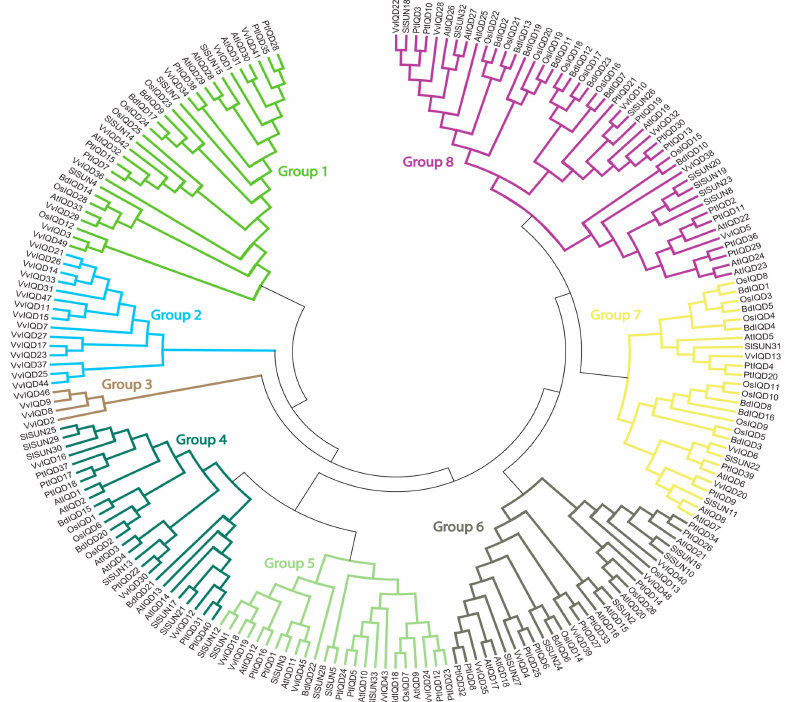
Figure 3. Phylogenetic relationships of V. vinifera VvIQD genes with A. thalinana , P. patens , O. sativa , S. lycopersicum , and B. distachyon . The phylogenetic tree was drawn by using the maximum likelihood (ML) method with 1000 bootstrap replicates in MEGA (Version